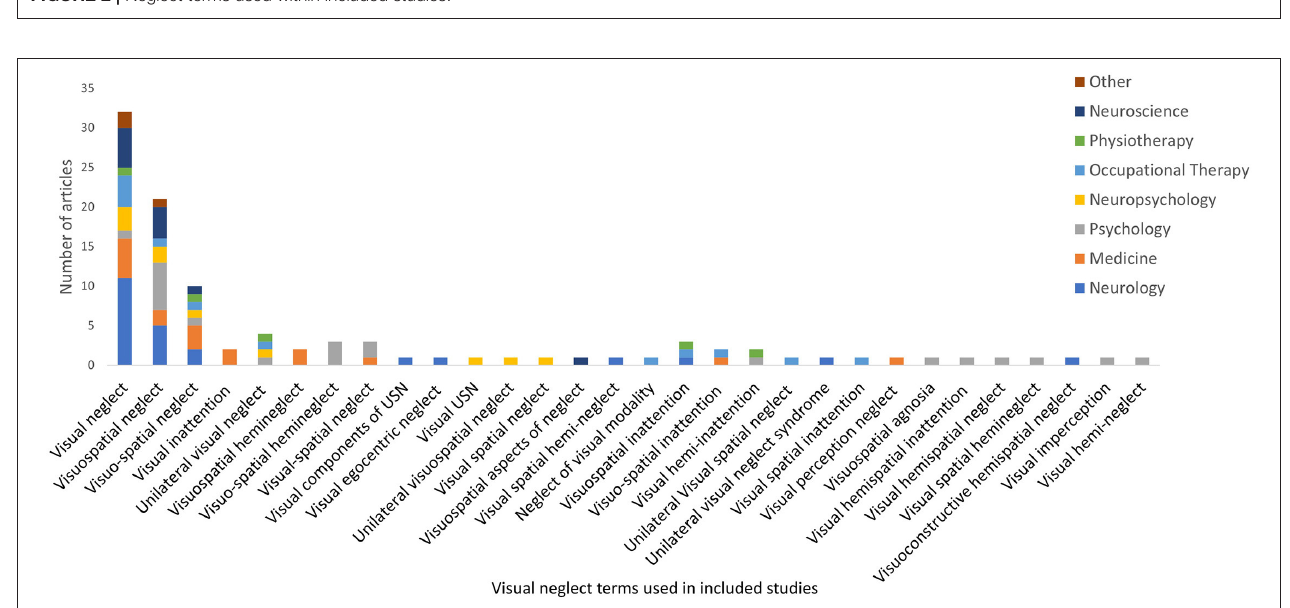
FIGURE 3 | Visual neglect terms used within included